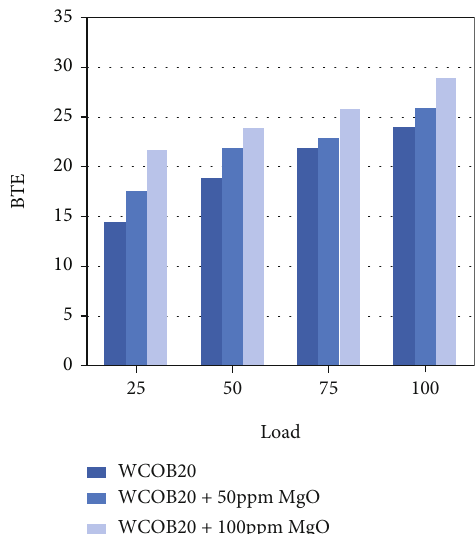
Figure 10: Load vs. carbon monoxide.